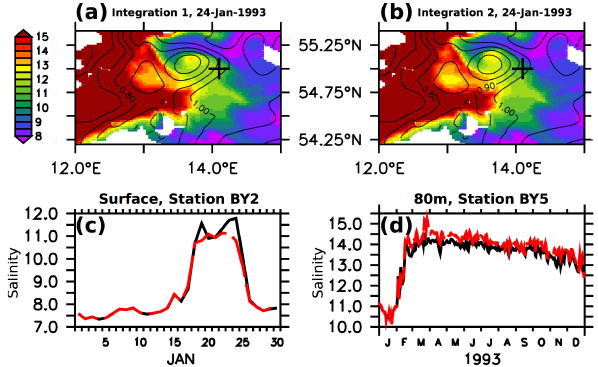
Figure 21. (a) Simulated surface salinity (colour) and sea surface height (black contours in units of metres). The black cross denotes station BY2. (b) Almost identical to (a) but slightly different due to “computational uncertainty”. (c) Temporal evolution of sea sur- face salinity at station BY2. The black and red line correspond to 57 identical setups which differ due to “computational uncertainty”. (d) Temporal evolution of salinity at 80m depth at station BY5. Black and red lines are coded like in (c) . The locations of stations BY2 and BY5 are shown in Fig.